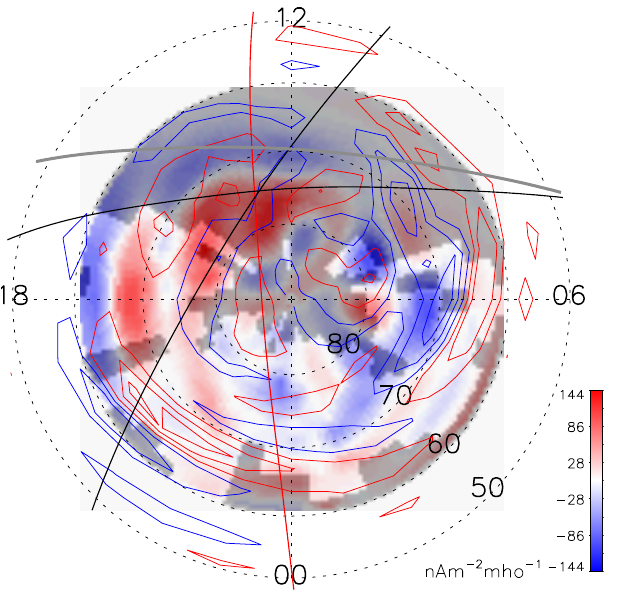
/6 P calculated from the divergence of the inertial Fig. 8. J O · E electric field for 1 November, 2001 as shown in Fig. 7. The contours of J obtained from the satellite data are overlayed for comparison. k The shaded regions indicate where there were no radar returns. Note that the colour range differs from Fig. 6 due to the 6 − 1